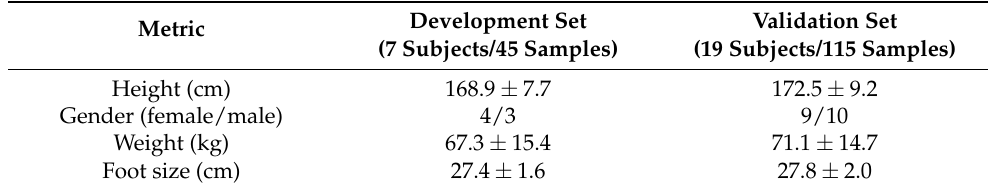
Table 1. Dataset characteristics after splitting.